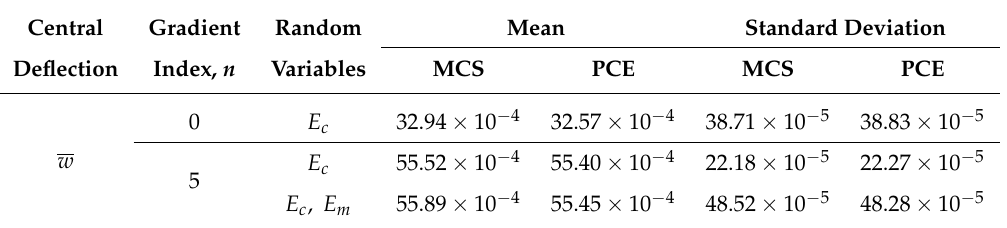
Table 5. Comparison of the mean and the standard deviation of the normalised central deflection for different cases between the Monte Carlo simulation (MCS) and the polynomial chaos expansion (PCE), considering PCE of order